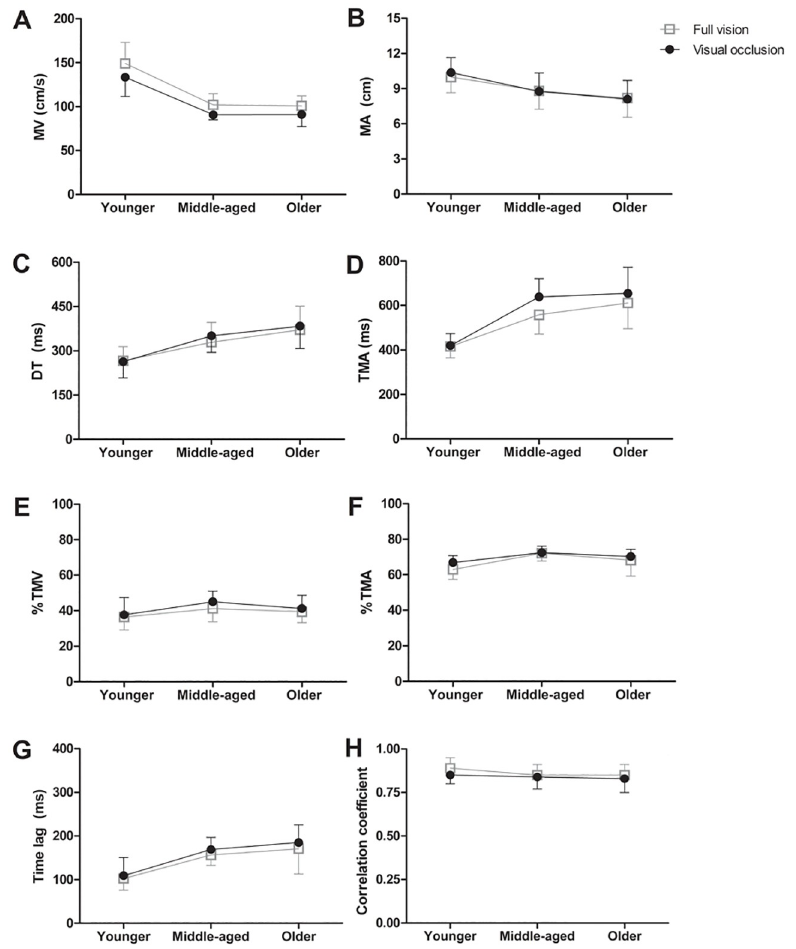
Fig 5. (A-H). Illustration of dependent variables in full-vision and visual occlusion conditions in each age group. Maximum transport velocity (MV) (A), maximum aperture (MA) (B), deceleration time (DT) (C), absolute time of maximum aperture (TMA) (D), relative time of maximum transport velocity (%TMV) (E), relative time of maximum aperture (%TMA) (F), maximum time lag (T max ) (G), maximum correlation coefficient (r max ) (H). No significant interaction of age-by-visual condition. Error bars represented standard